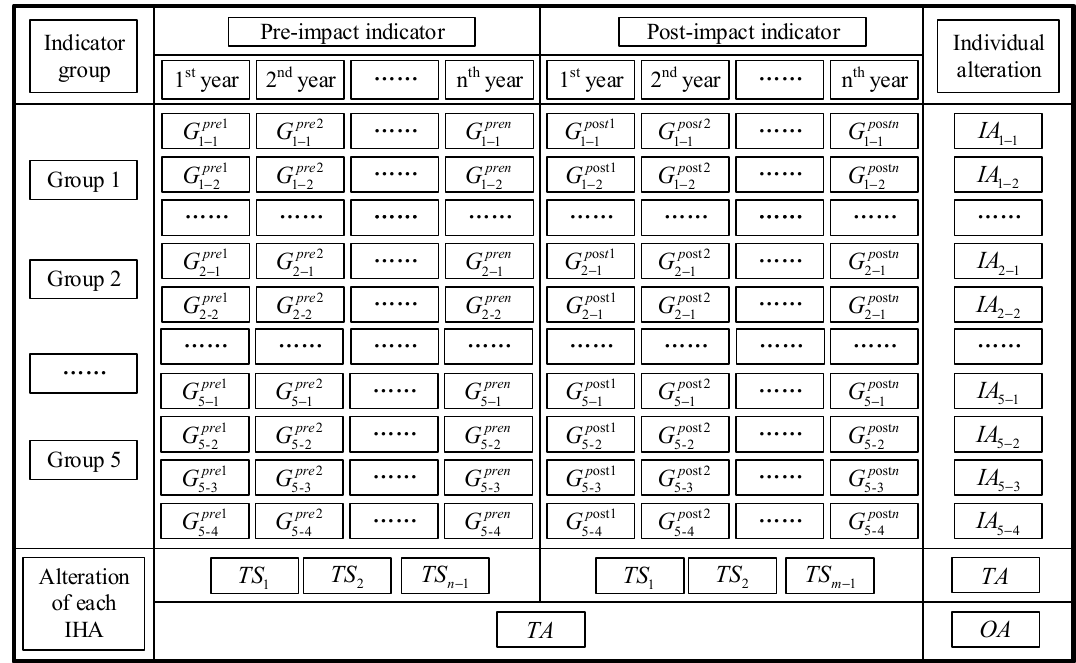
Figure 1. Main idea of the revised range of variability approach (RVA) method.